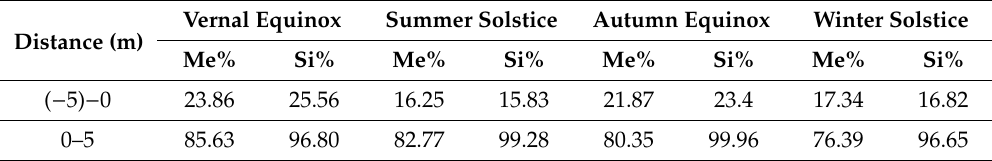
Comparisons of measured and simulated calculation rate of change results (mixed weather pattern).